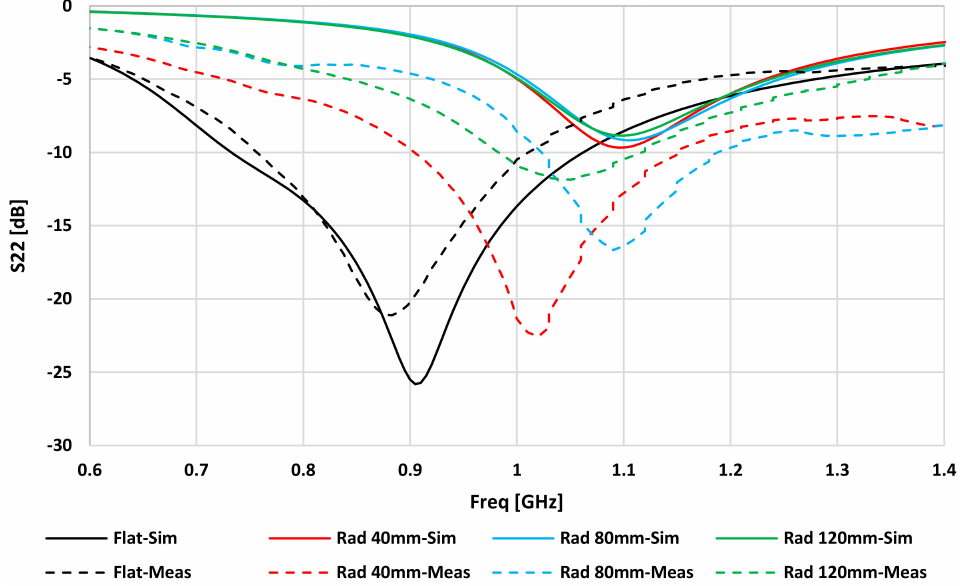
Figure 7. Simulated and measured IM reflection coe ffi cients (S 22 ) for flat and three bending cases (Kapton thickness of 0.15